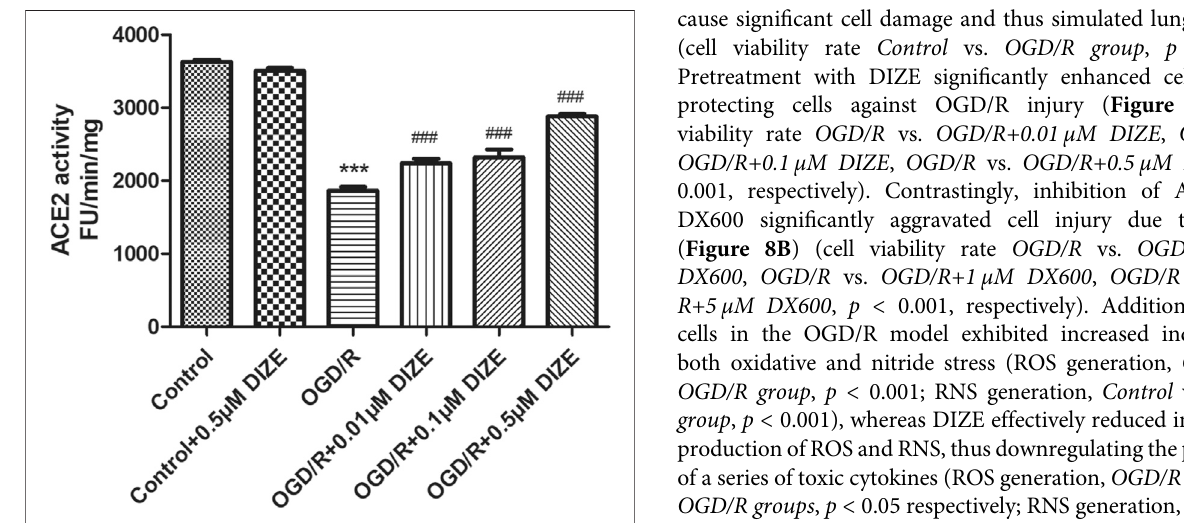
FIGURE 9 | DIZE protected ACE2 enzyme activity during OGD/R injury. OGD/R injury signi fi cantly decreased ACE2 activity in A549. DIZE pretreatment (0.01, 0.1, 0.5 μ M) preserved higher ACE2 enzyme activity during OGD/R injury in A549. ***p < 0.001 vs. Control group ; ### p < 0.001 vs. OGD/R group